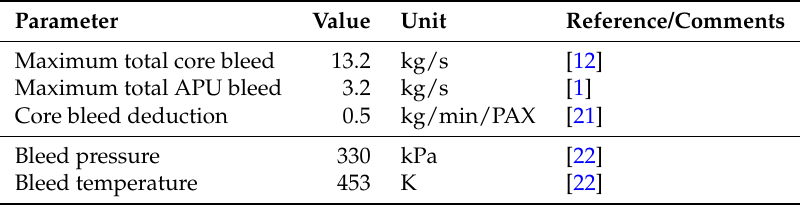
Table A1. Summary of technology state-of-the-art parameters, operational parameters, component efficiencies, material properties, and other